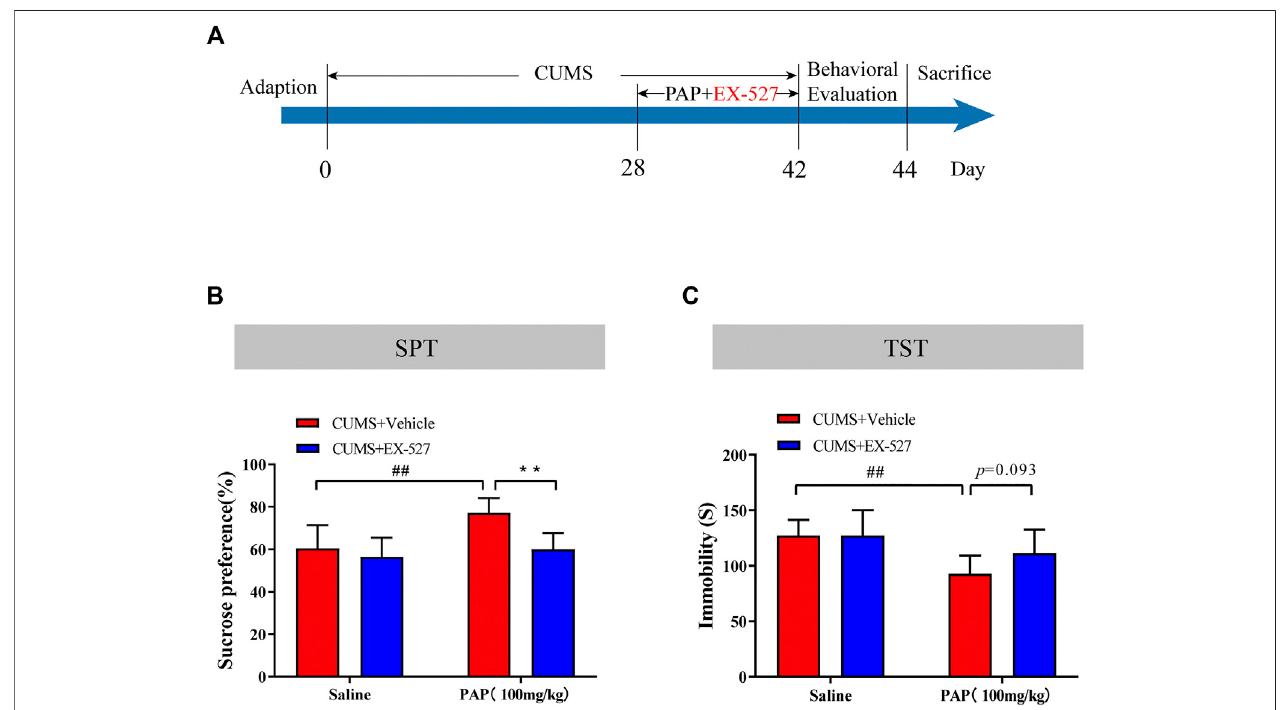
FIGURE 4 | Role of Sirt1 in the attenuation of PAP on CUMS-induced depressive behavior. The schedule of CUMS induction and drug treatment in experiment 2 (A) . The sucrose preference in the SPT (B) . The immobility in the TST (C) . ## p < 0.01 vs. CUMS + Vehicle, ** p < 0.01 vs. CUMS + Vehicle + PAP group.